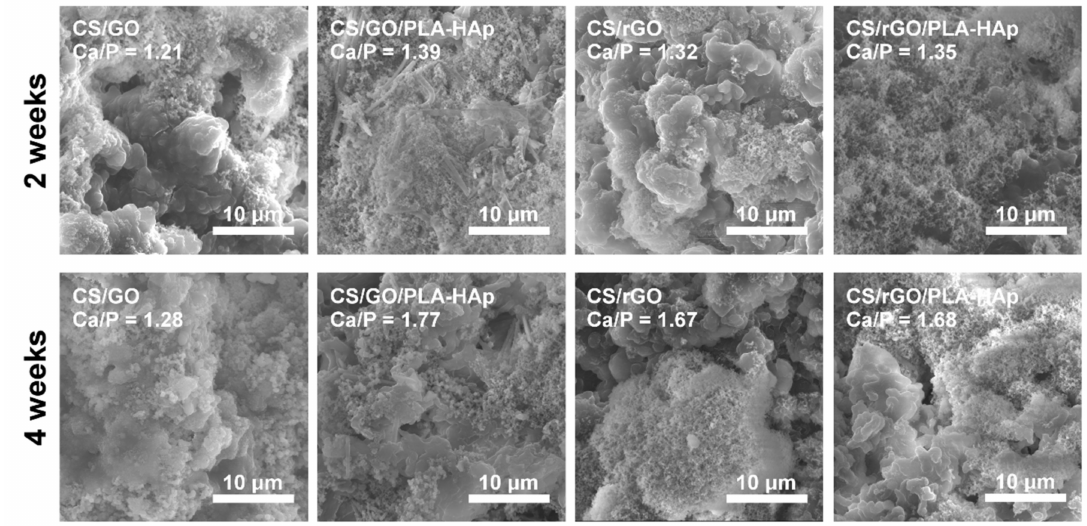
Figure 10. Representative SEM images of the samples surface after 2- and 4-weeks incubation in simulated body fluid, at 37 ◦ C with Ca / P ratios calculated from EDX analyses.